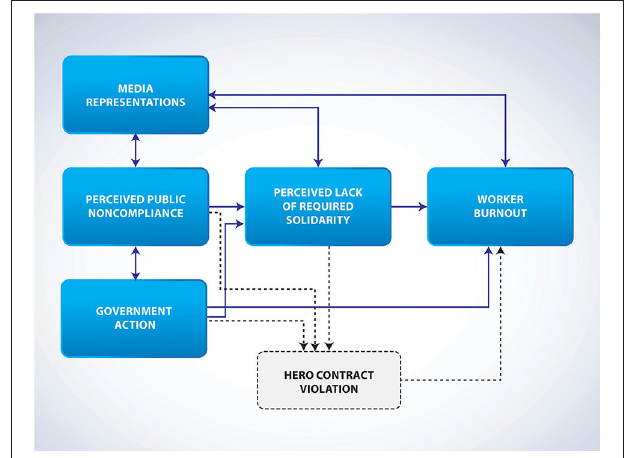
FIGURE 2 | The social contextual factors that contribute to burnout via solidarity appraisal.